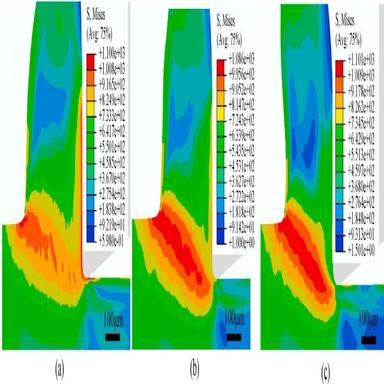
Simulation results of von Mises stress distributions in the cutting deformation zones. (a)–(c) successively present the simulation results at 30 m/min, 90 m/ min and 150 m/min.